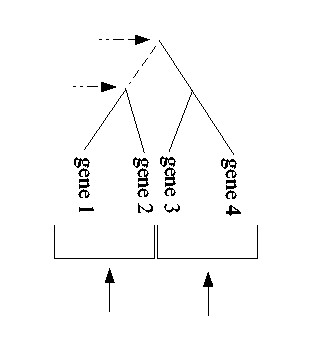
While comparing gene expression values between extant species averages over several branches of a phylogenetic tree, considering change along a branch based upon consideration of ancestral character states increases the signal to noise ratio, resulting in a test with more power to detect causative changes.